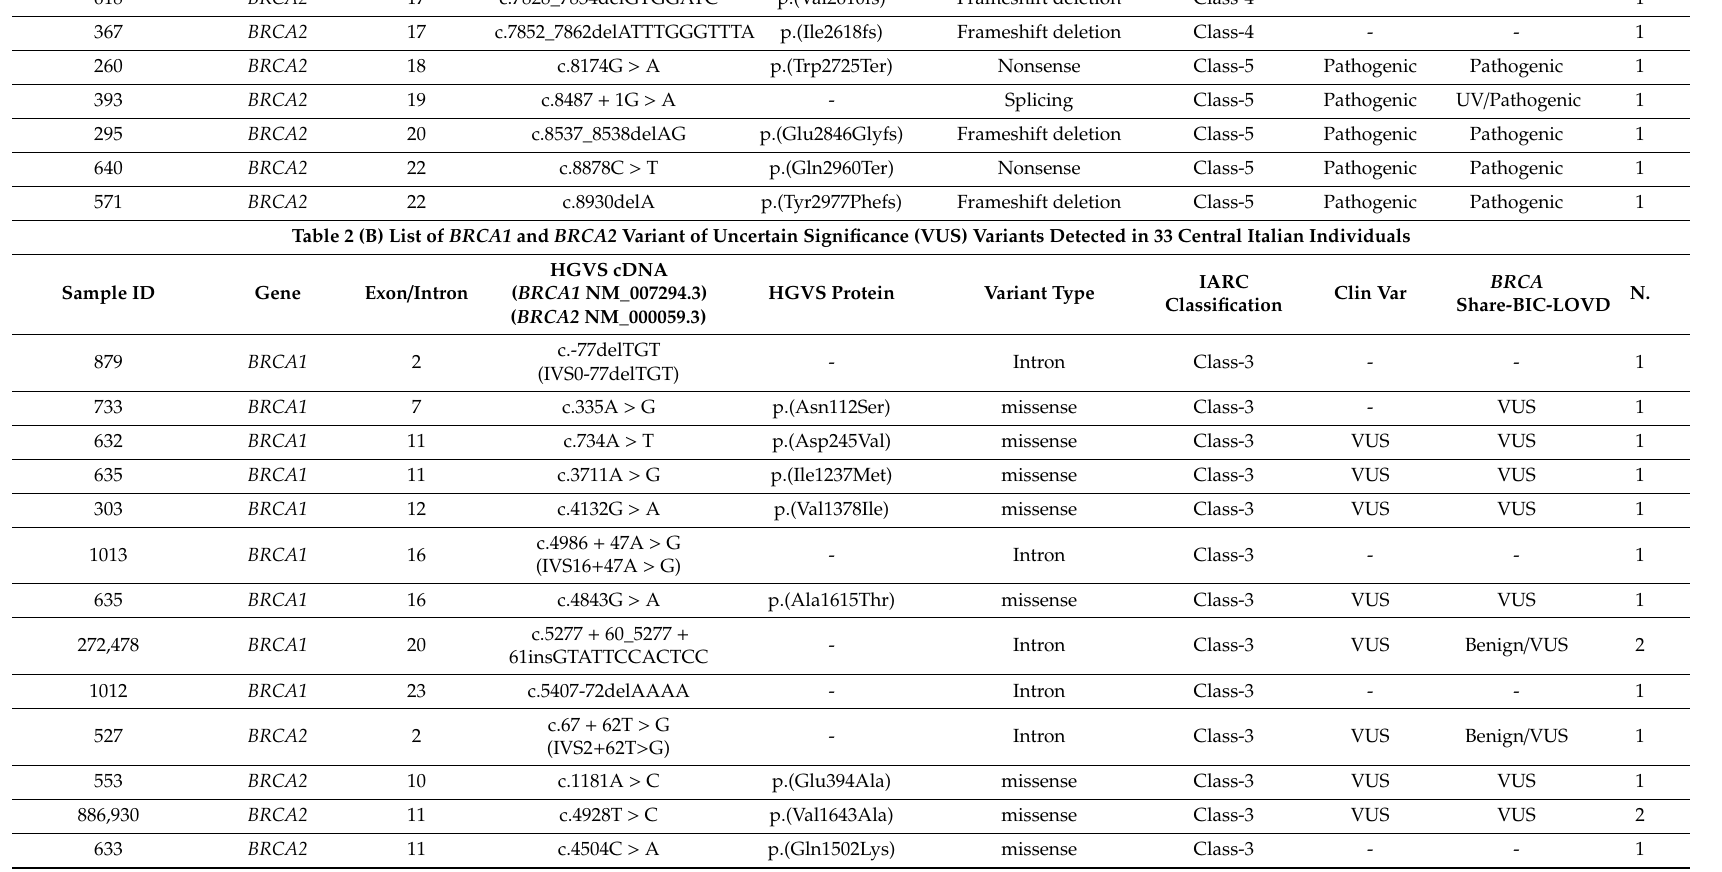
Table 2. Cont. Table 2 (A) List of BRCA1 and BRCA2 Pathogenic / Likely-Pathogenic Variants Detected on 50 Central Italian Individuals